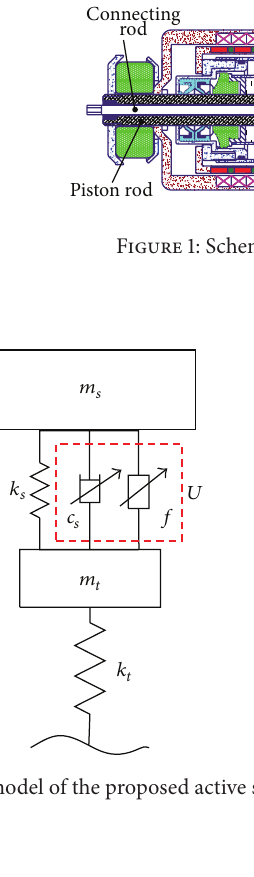
of HASAS, as shown in Figure 2. The actuator force can be equivalent to the sum of adjustable damping forceand motor thrust 𝑓 . Sprung mass and unsprung mass are denoted by 𝑚 𝑘 𝑘 𝑚 𝑠 and 𝑡 , respectively. The symbols 𝑠 and 𝑡 represent the suspension stiffness and tire stiffness, respectively. Adjustable damping of the shock absorber is marked by 𝑐 𝑠 . 𝑧 𝑠 and 𝑧 𝑡 are vertical displacements of sprung mass and unsprung mass, respectively, while 𝑧 𝑟 stands for the road